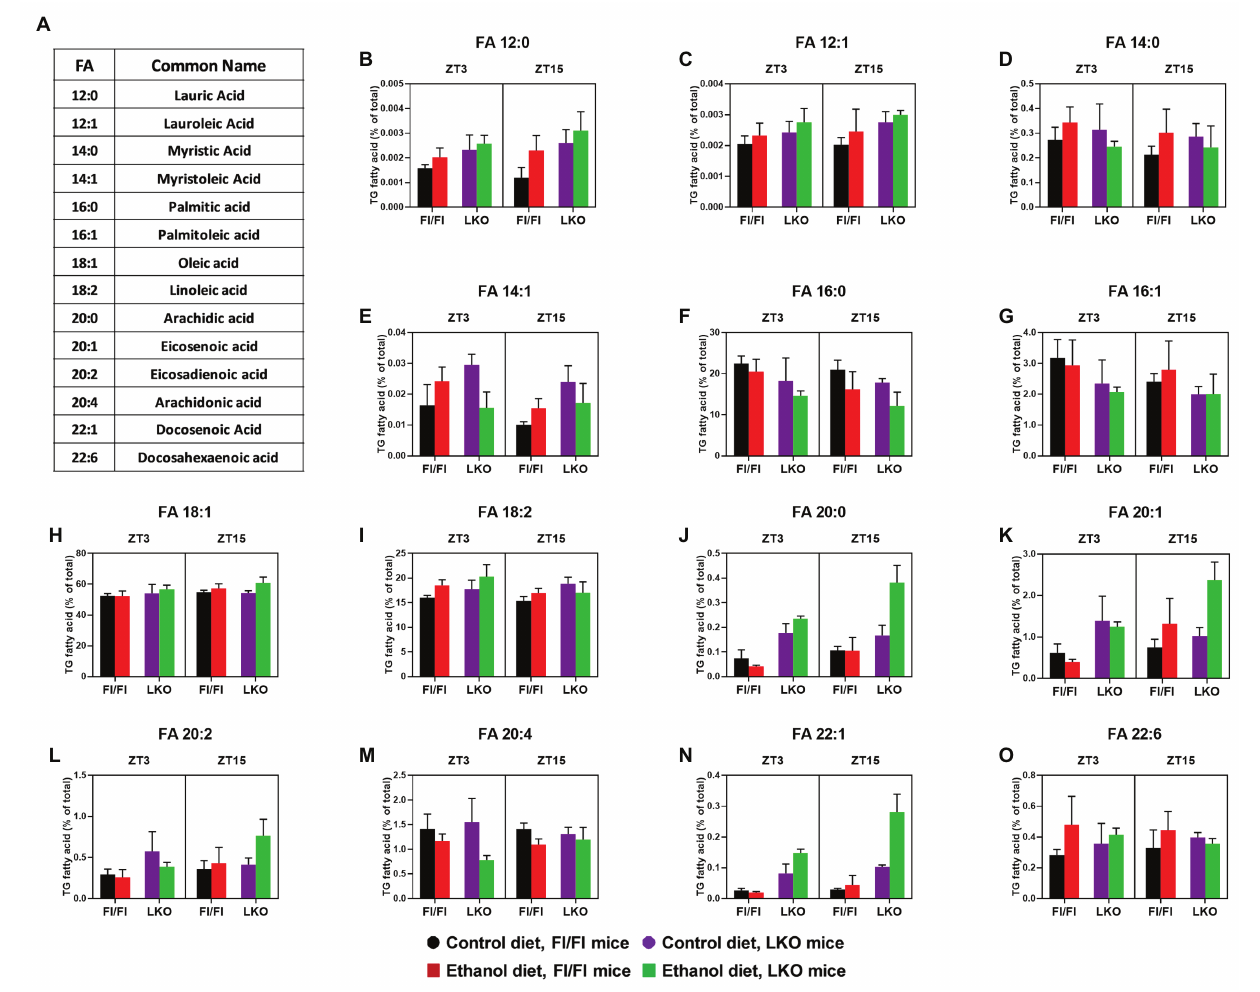
FIGURE 10 | Chronic alcohol and liver clock disruption differentially alter triglyceride fatty acid composition in the liver. Fatty acids (FA, B–O ) as a percentage of the total triglyceride (TG) FA pool was determined in liver lipid extracts from control-fed (black) and alcohol-fed (red) Bmal1 Flox/Flox (Fl/Fl) and control-fed (purple) and alcohol-fed (green) Bmal1 liver-specific knockout (LKO) mice at ZT 3 and ZT 15 (ZT 0: lights on/inactive period, ZT 12: lights offs/active period) using MS/MS ALL . FA common names and structure are shown in panel (A) . Data are mean ± SEM for n = 3–4 mice/genotype/diet/time-point. Results for ANOVA analyses and relevant pair-wise comparisons are provided in Supplementary Tables 9–12 ,